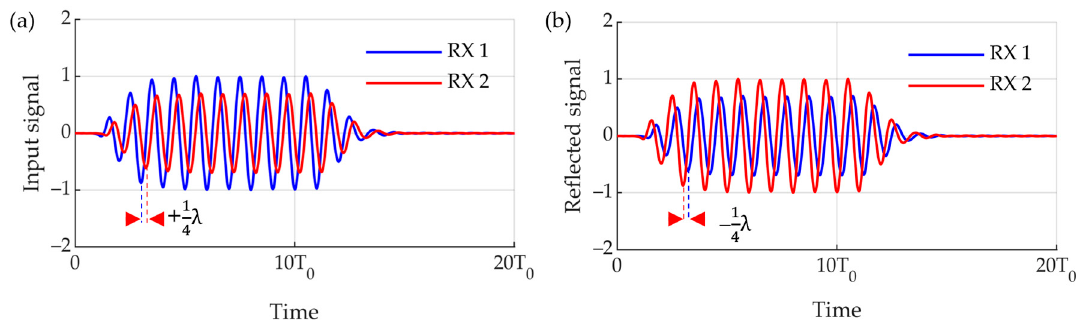
Figure 2. Time delay separation method. ( a ) Time delay of RX1 and RX2 in case of incident wave ( b ) time delay of RX1 and RX2 in case of reflected wave.